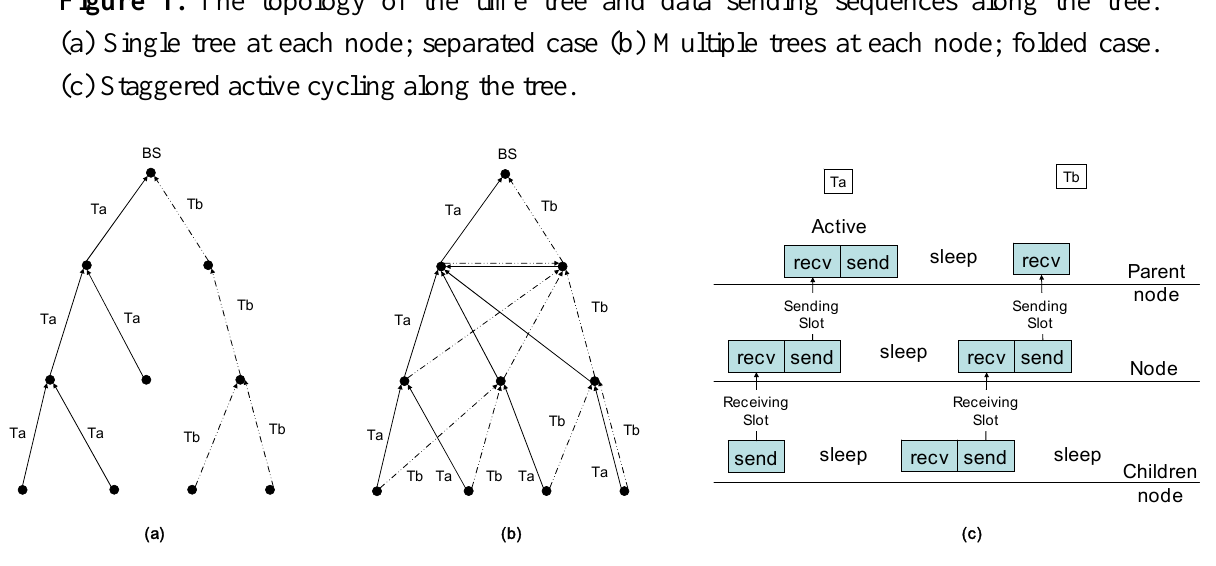
Figure 1. The topology of the time tree and data sending sequences along the